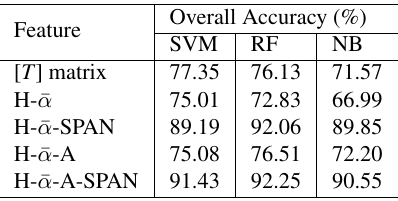
Table 4. Classification Accuracy (Overall accuracy)